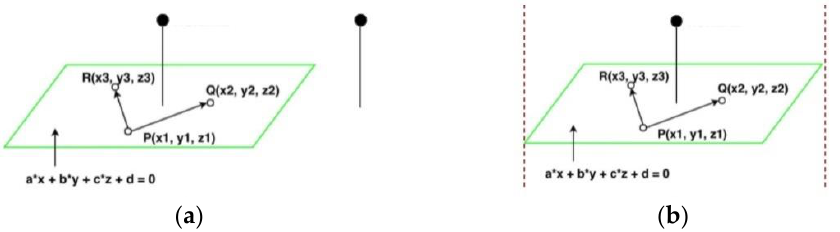
Figure 7. Plane limits: ( a ) calculates the distance to all points, ( b ) discards the points that are outside the limits of the current plane.